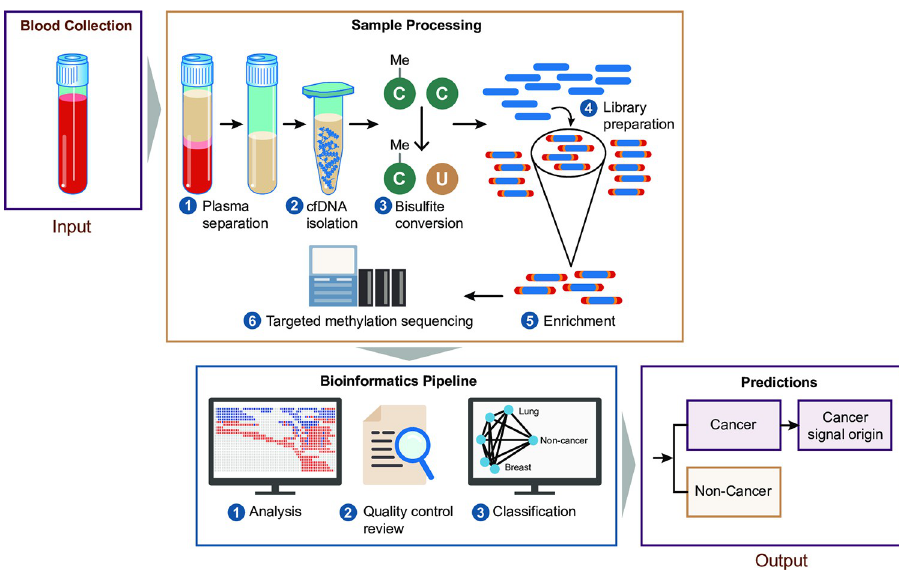
Fig 1. Overview of the multi-cancer early detection test workflow and computational pipeline. Cell-free DNA (cfDNA) fragments are isolated from plasma and are treated with bisulfite to distinguish methylation patterns. Sequencing libraries are generated, are enriched for > 100,000 genomic regions previously identified as having cancer- and/or tissue-specific methylation patterns, and then undergo targeted methylation sequencing. Following an initial analysis, if the data pass a quality-control review, a machine-learning classifier analyzes the targeted methylation sequencing data from cfDNA fragments to determine cancer status and, if cancer is detected, predict the cancer signal origin (16). C, cytosine; cfDNA, circulating cell-free DNA; Me, methyl group; U, uracil.